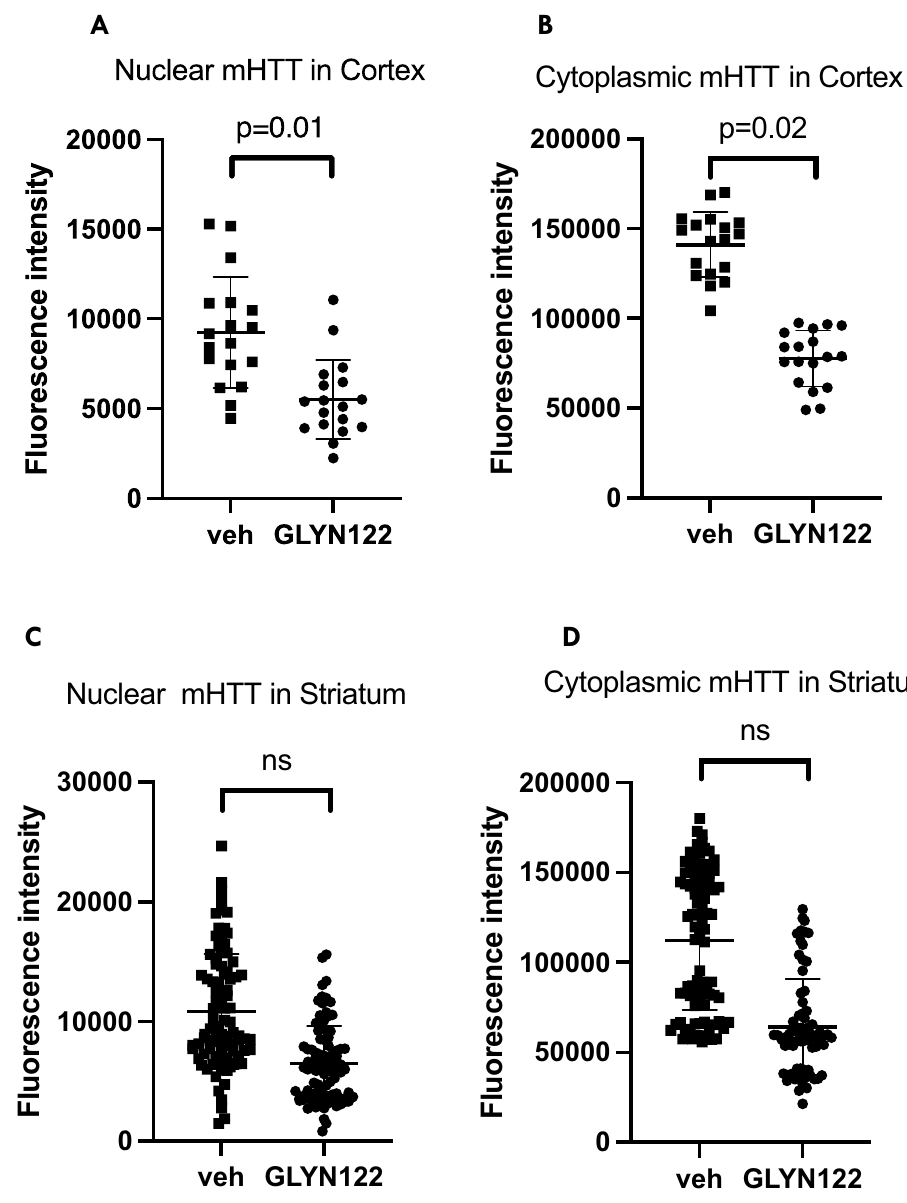
Figure 6. Diffuse mHTT reduction in the cortex (6A,6B) and striatum (6C,6D). Compared to a vehicle (veh), administration of GLYN122 reduced diffuse mHTT in the cortex by 40% in the nucleus (6A) and by 45% in the cytoplasm of treated TG mice (* p = 0.01 and p = 0.02, respectively). Likewise, GLYN122 reduced diffuse mHTT in the striatum by 40% in the nucleus (6C) and 43% in the cytoplasm (6D) compared to vehicle (veh) of treated TG mice ( p = 0.14 and p = 0.06, respectively). The points on the graph represent different samples of the same